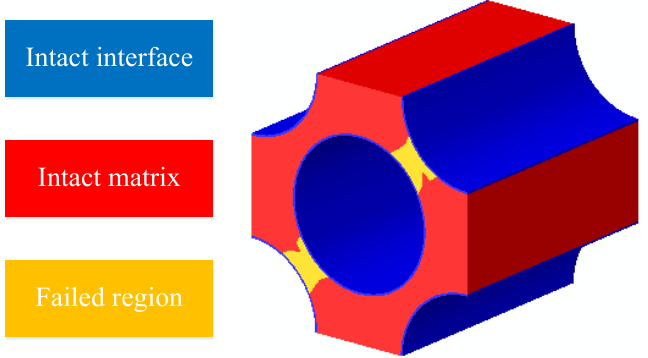
Figure 12. Illustration for one failure pattern of matrix and interface. Table 3. Performance of the trained FFNN for fiber diamond distribution model.